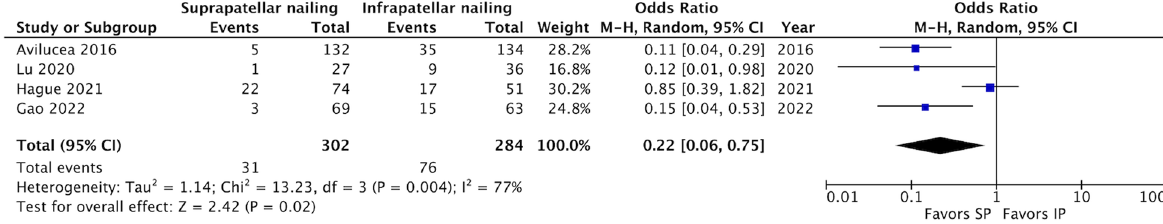
Fig. 6 Forest plot of the malalignment. The SP group had a lower risk for postoperative malalignment than the IP group (OR: 0.22; 95% CI 0.06 to 0.75; NNT: 6 (95% CI 5 to 20); P 0.02; I 2 77%). CI confidence interval, NNT number needed to treat, OR odds ratio = =